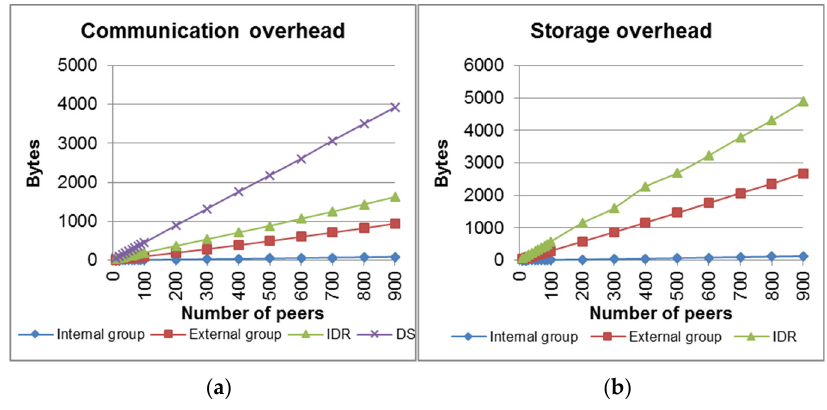
Figure 4. Communication ( a ) and storage ( b ) overheads in bytes for a system with delays from 0 to 50 milliseconds.